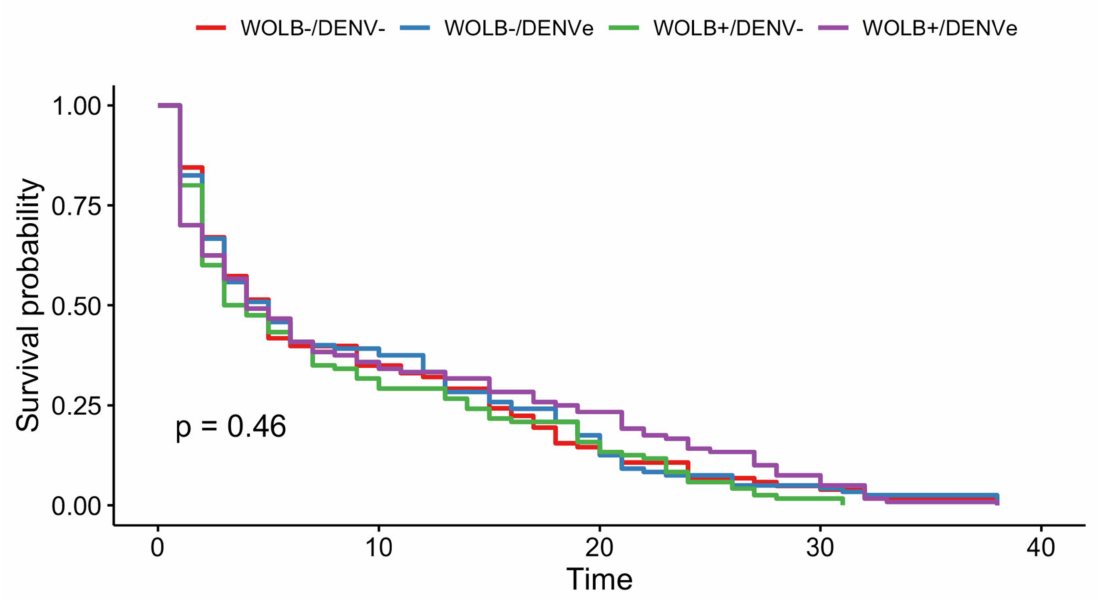
Figure 4. Daily survival of mosquitoes with or without Wolbachia (WOLB+/WOLB − ) and exposed or unexposed to DENV-1 (DENVe/DENV − ). Log-rank test p =